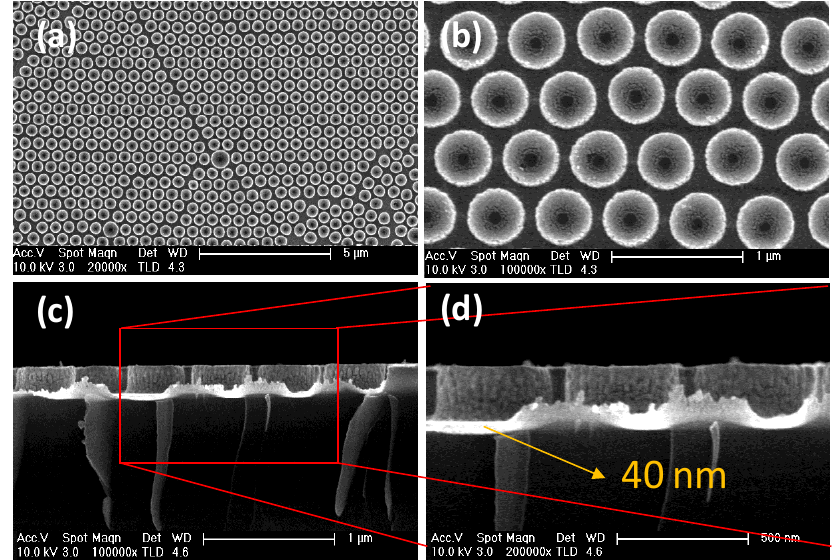
Figure 5. General FESEM view of the in plane order and presence of defects in Au / Si Π structures formed after 240 s RIE and 280 s sputtering of Au with no further post-processing ( a ). Higher magnification image highlighting the absence of Au on the center and its presence on the lateral part ( b ). Cross section view confirming the Au lateral coating ( c ) and a higher magnification ( d ) providing mean thickness at the base and details of the columnar morphology at the pillar edge.